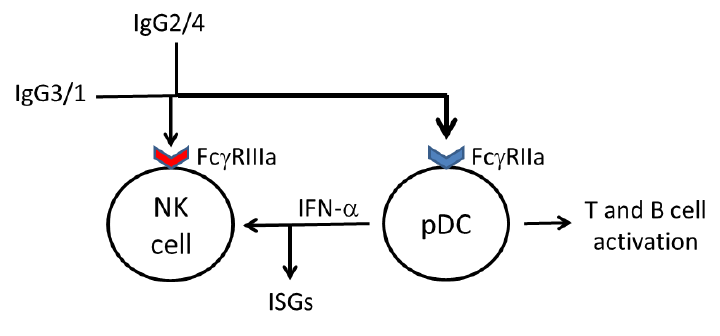
Figure 2. A diagrammatic representation of how isotype diversification of IgG antibodies against HIV-1 Gag proteins might enhance anti-viral accessory cell responses against HIV-1 infection. It is proposed that IgG antibodies bind to HIV-1 Gag proteins expressed on the surface of cells infected by HIV-1, including resting CD4 + T-cells [9]. Activation of natural killer (NK) cells is elicited by “downstream” IgG isotypes (IgG3 and IgG1) via Fc  RIIIa. “Upstream” IgG isotypes (IgG2 and possibly IgG4) may also contribute to NK cell activation by ligating Fc  RIIIa, particularly in individuals carrying the 158V genotype. However, it is proposed that multimeric IgG2 antibodies primarily broaden the function of the antibody response by enhancing phagocytic activity against Gag proteins associated with HIV-1 RNA, as a consequence of the functional characteristics of IgG2 (see Table 1), which activates plasmacytoid dendritic cells (pDCs) via Fc  RIIa. Activation of pDCs leads to the production of IFN-  which facilitates NK cell responses and induces the production of interferon-stimulated genes (ISGs) and to antigen presentation and/or stimulation of B- and T-cells (see text). HIV-1 infection impairs diversification of an IgG antibody response to “downstream”